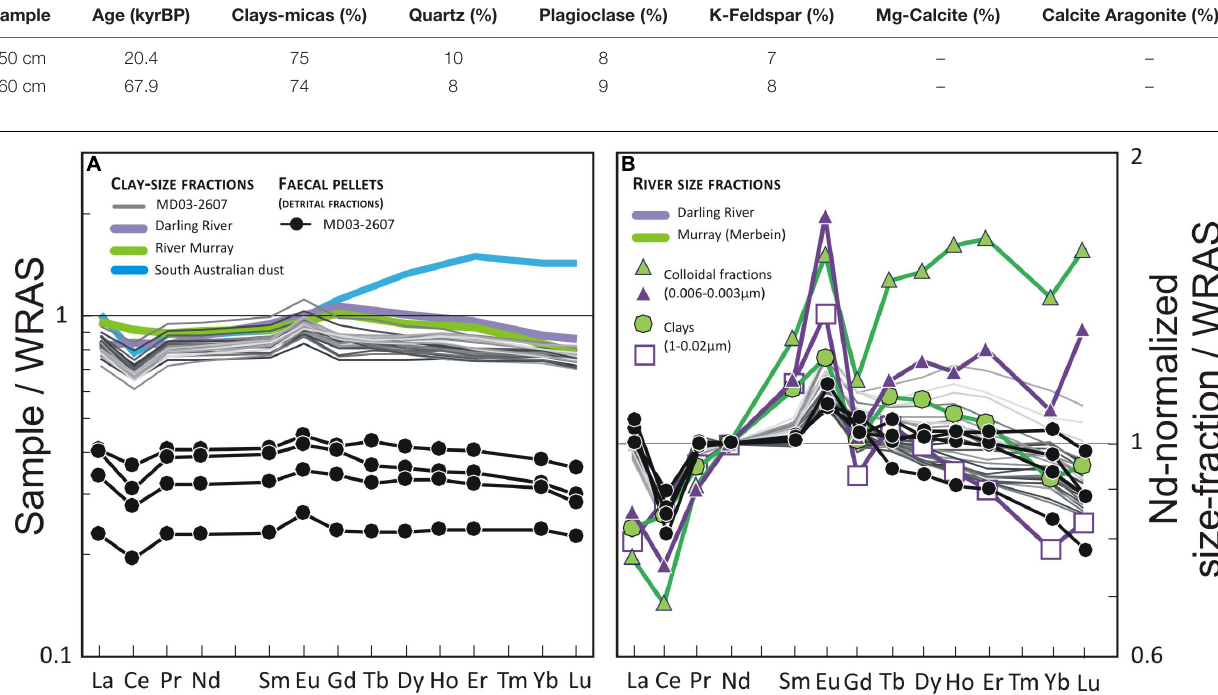
FIGURE 4 | (A) WRAS-normalized REE distribution patterns for clay-size fractions (gray lines) and fecal pellet separates (black circles) in core MD03-2607. For comparison are the average patterns for clay-size fractions from Murray (yellow line) and Darling (green line) watersheds (Gingele and De Deckker, 2005b). The blue line corresponds to the average REE pattern of Late Holocene clay-size fractions from nearby core MD03-2611 (Gingele et al., 2007), assumed to be representative of the fine-grained southern Australian dust component transported to the core site. (B) WRAS-normalized REE distribution patterns clay-size fractions (gray lines) and fecal pellet separates (black circles) in core MD03-2607, after normalization to Nd WRAS . For comparison are the patterns for studied clay- (1–0.2 µ m) and fine colloidal (0.006–0.003 µ m) size fractions of suspended loads from the Darling River and River Murray (Merbein)